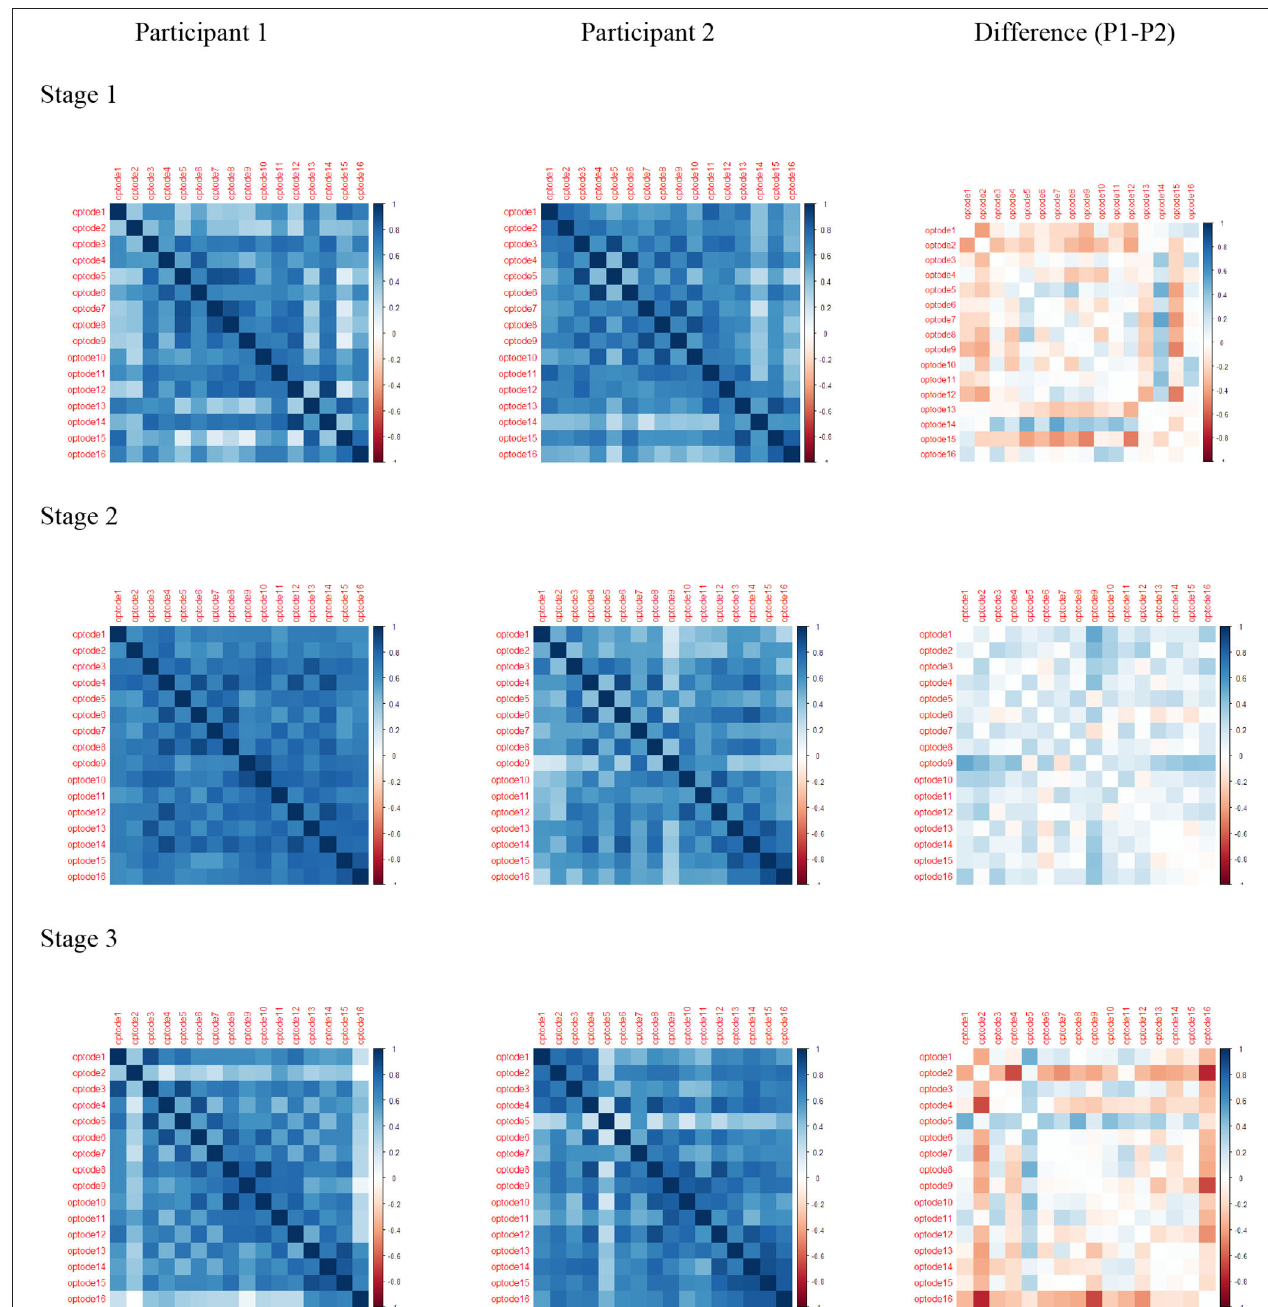
FIGURE 9 | Pearson correlations for HbO: rows are stage 1, stage 2, and stage 3; columns are Participant 1, Participant 2, and Difference (P1–P2).